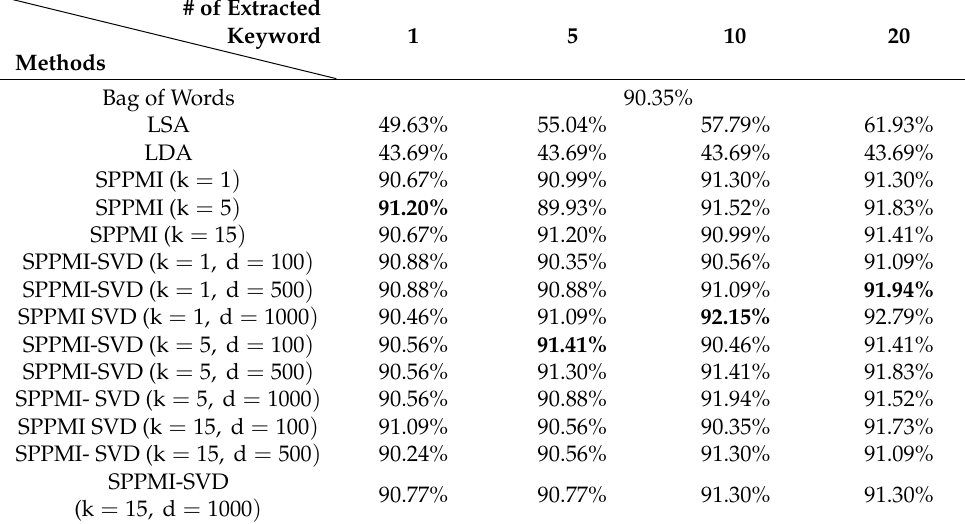
Table 5. Comparison of overall smoking status classification accuracy. All accuracies are reported in F1